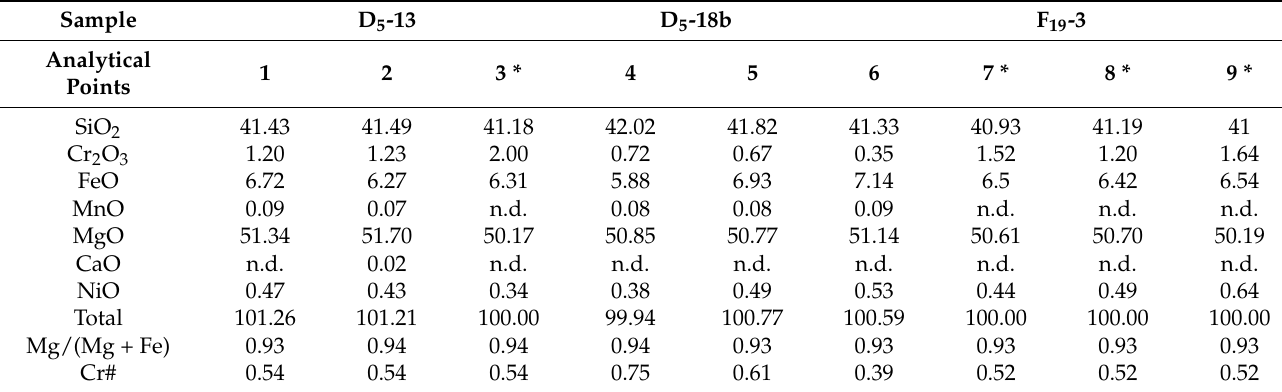
Table 3. The composition of olivine inclusions in chromite (wt.%).